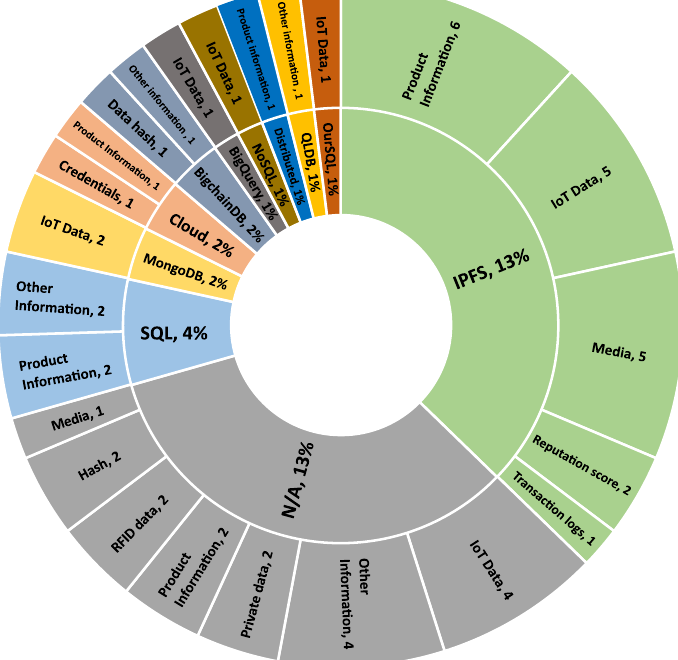
Figure 12. Types of data stored off-chain and the corresponding storage technology used. The groups shown in the external ring are overlapping, that is, some items might belong to more than one